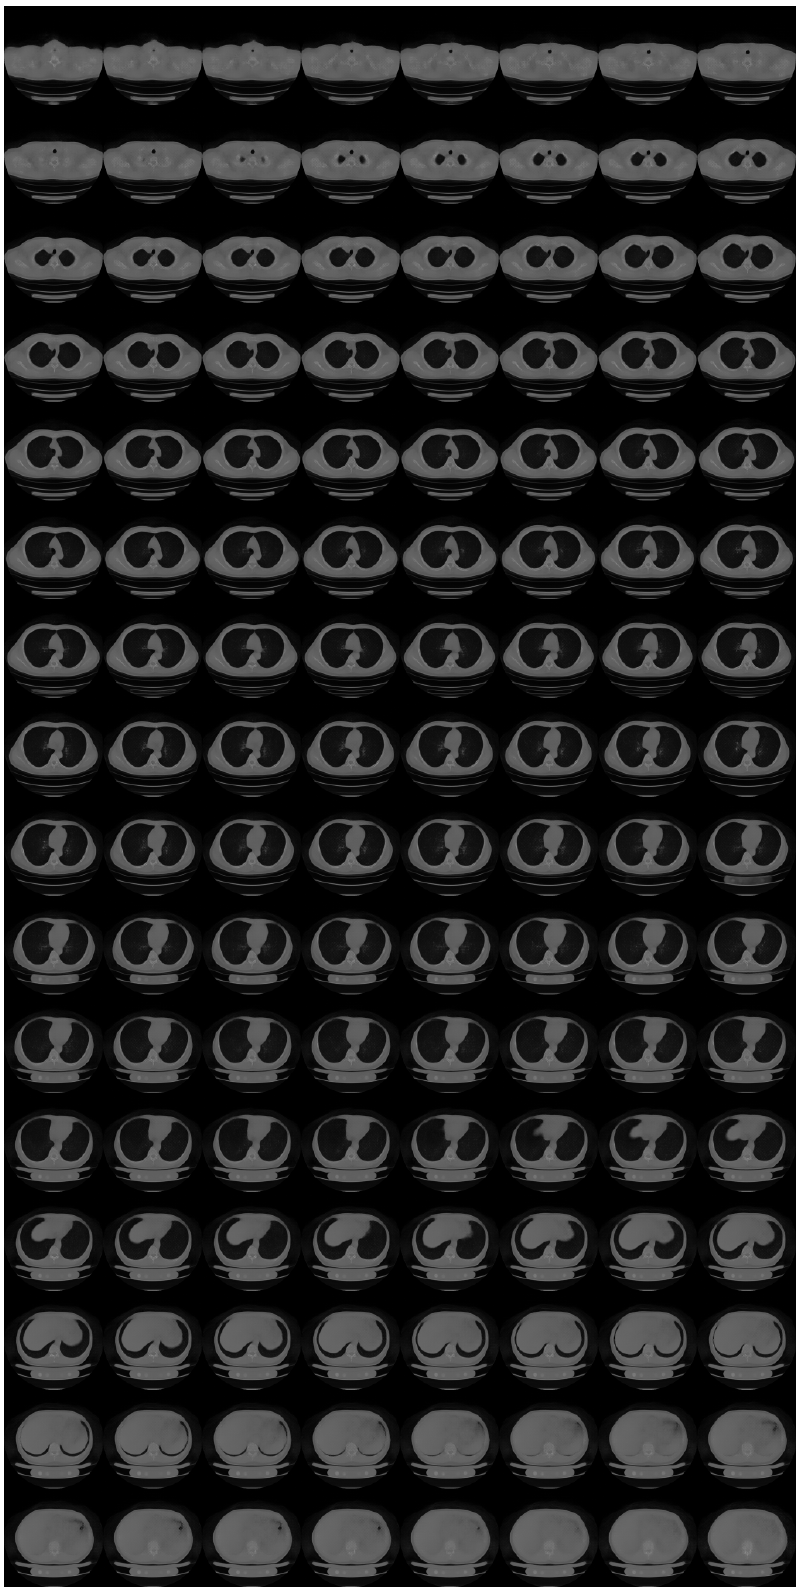
Figure A5. Fictional 3D CT image at the final epochs (sampled with T = 0.5, progressive learning, 3 of